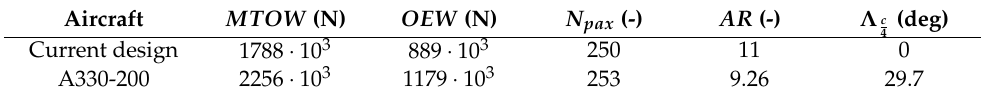
Table 1. Airframe design parameters (A330-200 data from [2]).